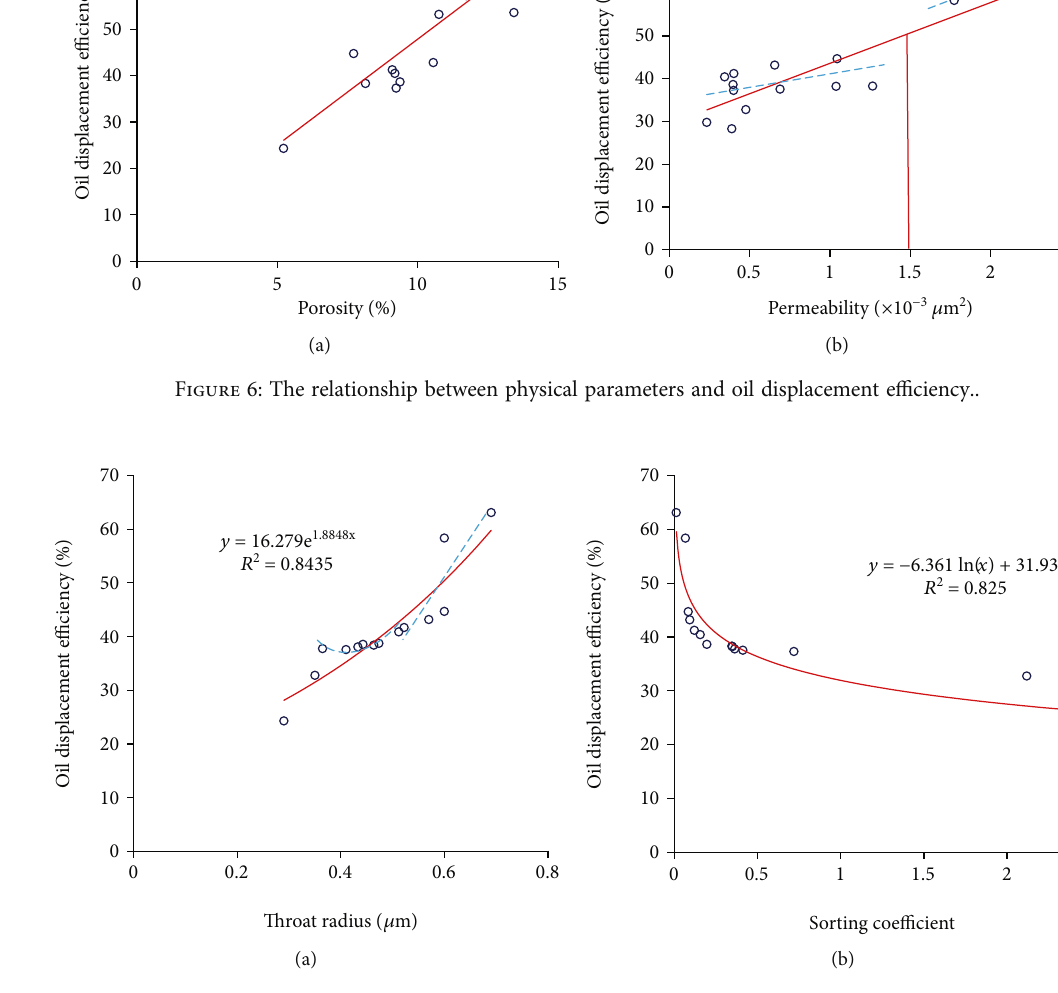
Figure 7: The relationship between pore throat parameters and oil displacement e ffi